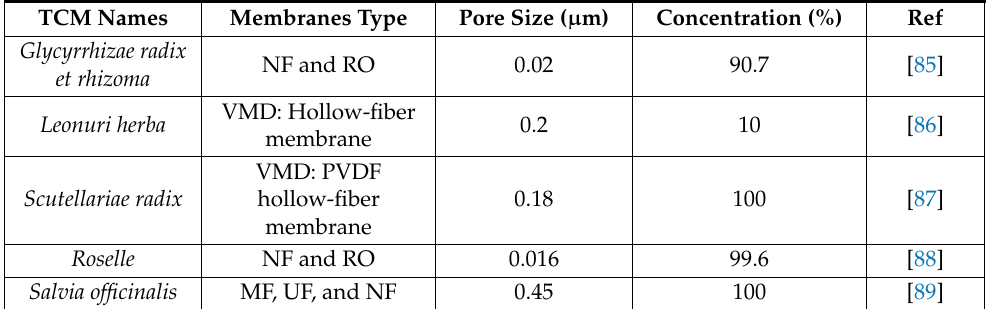
Table 2. Examples of applications of membrane technology on the concentration of TCM